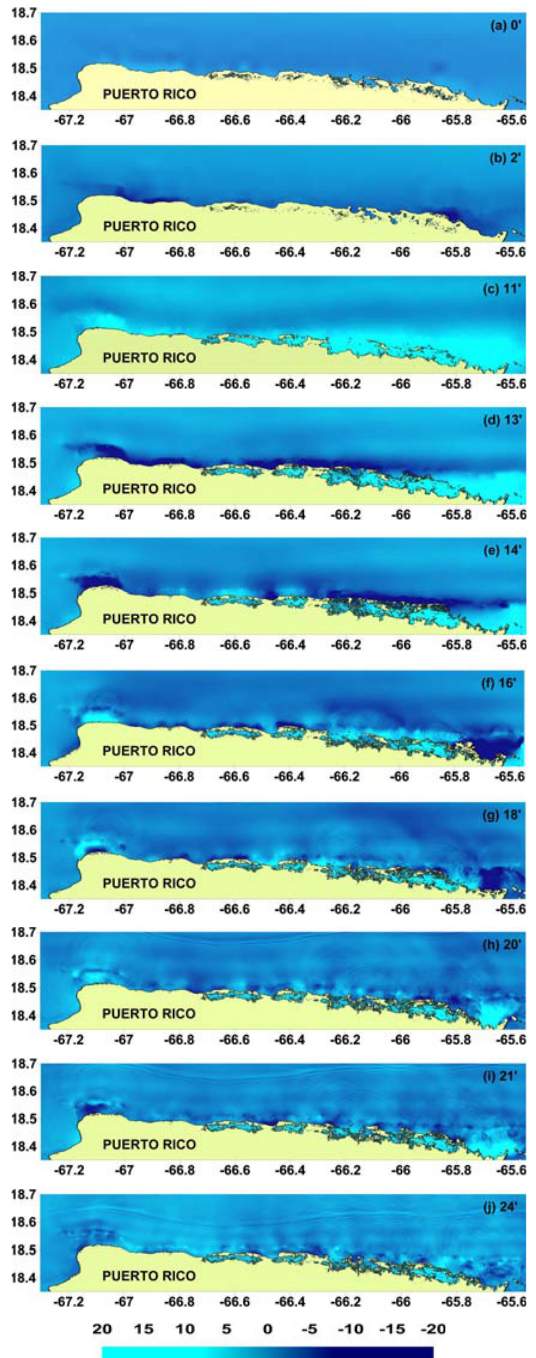
Fig. 6. Snapshots of surface elevations (color bar scale in me- ter; dark blue below MWL; light blue above MWL; light yellow: emerged), simulated in a 3 00 model grid, for the M =9.1 PRT co- seismic tsunami source (Fig. 2a), using the 3 00 bathymetry of Fig. 5. The sequence (a–j) corresponds to 0–24min after the arrival of the tsunami onshore (350s after the start of the event, at initialization of elevations in the small regional grid, from 2 0 basin results of Figs. 1 and 3). [Small linear waves seen incoming in (h–j) are spurious waves resulting from small grid initialization, which do not influ- ence computed runups and inundations.]